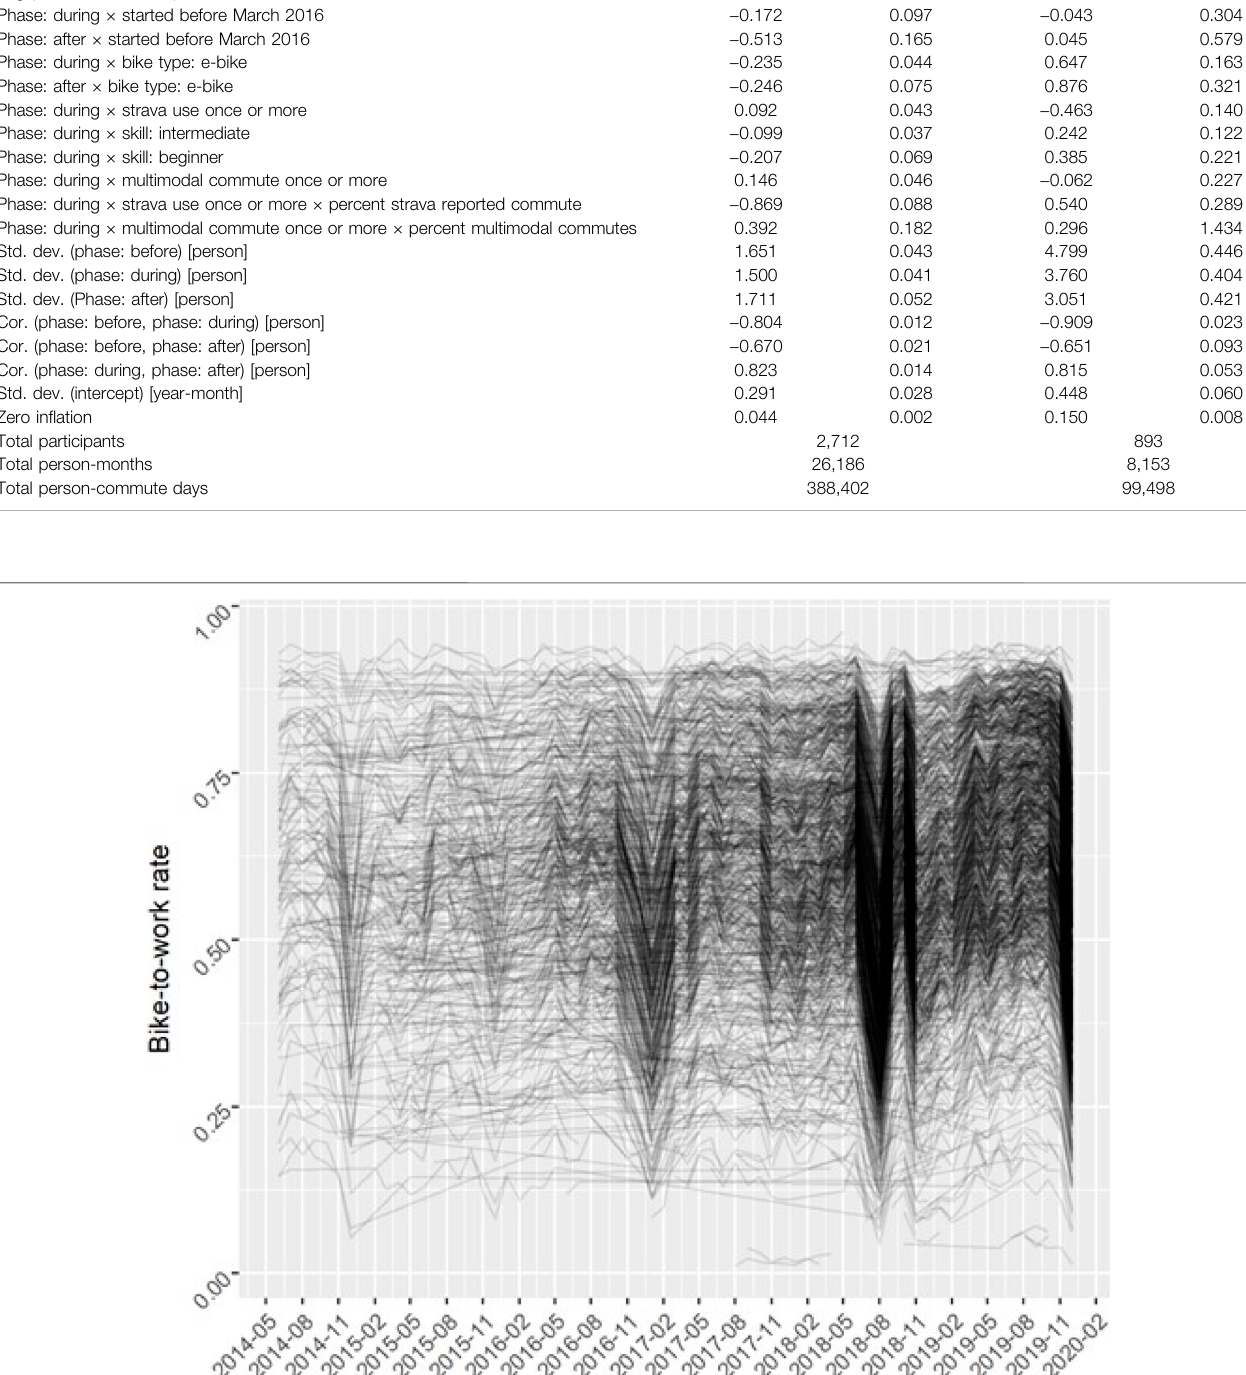
Frontiers in Future Transportation |